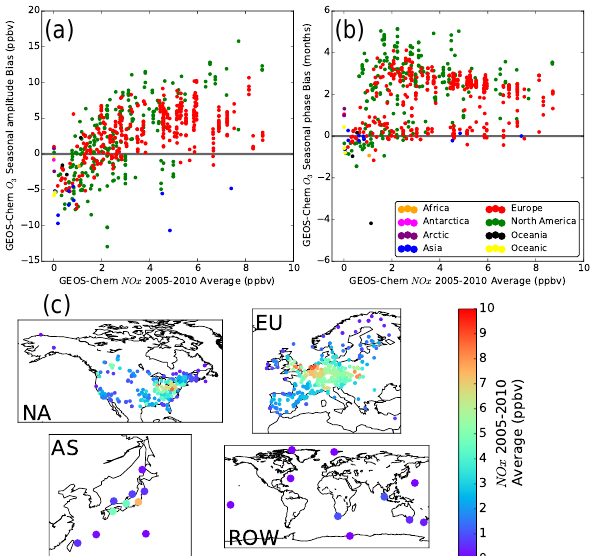
Figure 13. (a) Seasonal amplitude bias vs. 2005–2010 Average GEOS-Chem model NO x , (b) Seasonal phase bias vs. 2005–2010 Average GEOS-Chem model NO x , (c) 2005–2010 Average GEOS- Chem model NO x by observational site. NA is North America, EU is Europe, AS is Asia, and ROW is rest of